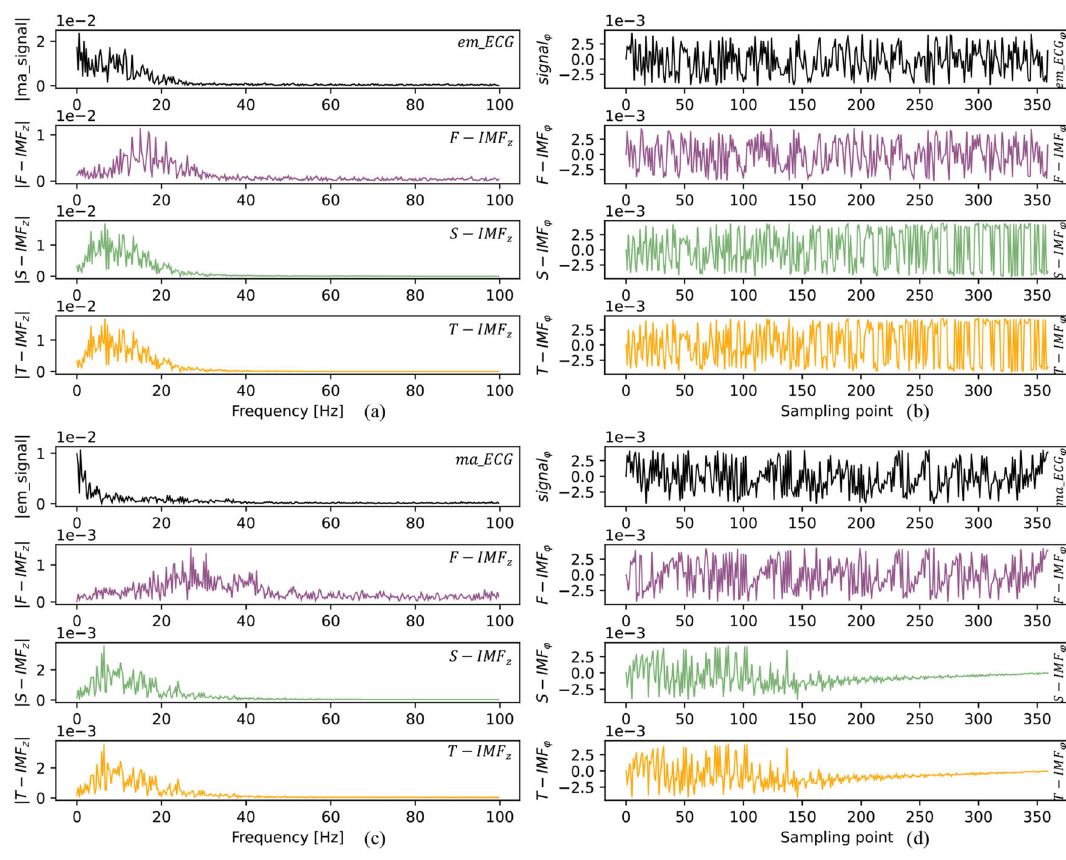
IMF of the em-contaminated ECG. c Amplitude–frequency features diagram of FT-IMF of the ma-contaminated ECG. d Phase angle dia- gram of FT-IMF of the ma-contaminated